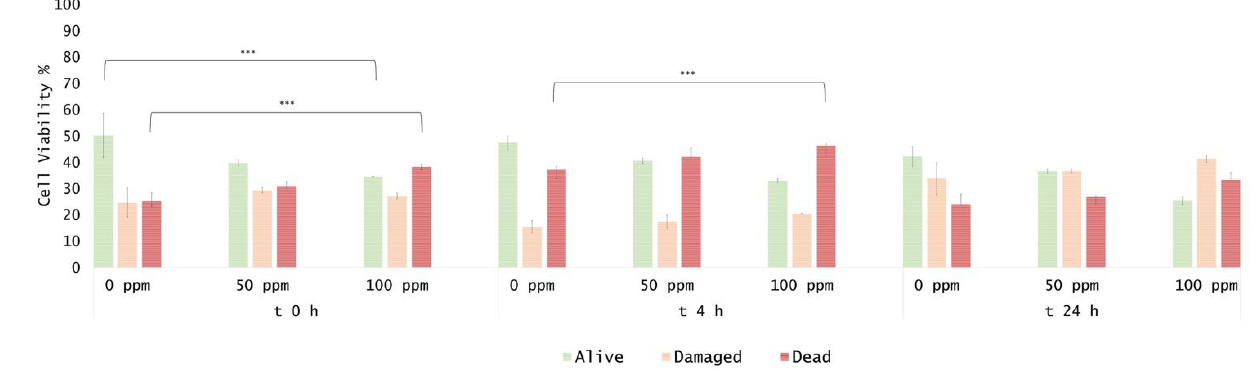
Figure 4. Percentage of alive, dead, and damaged cells calculated on total FCM events (100%): 50 ppm and 100 ppm OEO treatment at 0, 4, and 24 h compared to 0 ppm. The shown values correspond to the means and standard deviations for replicates, independently analysed. p -value less than 0.001 is flagged with three stars (***).